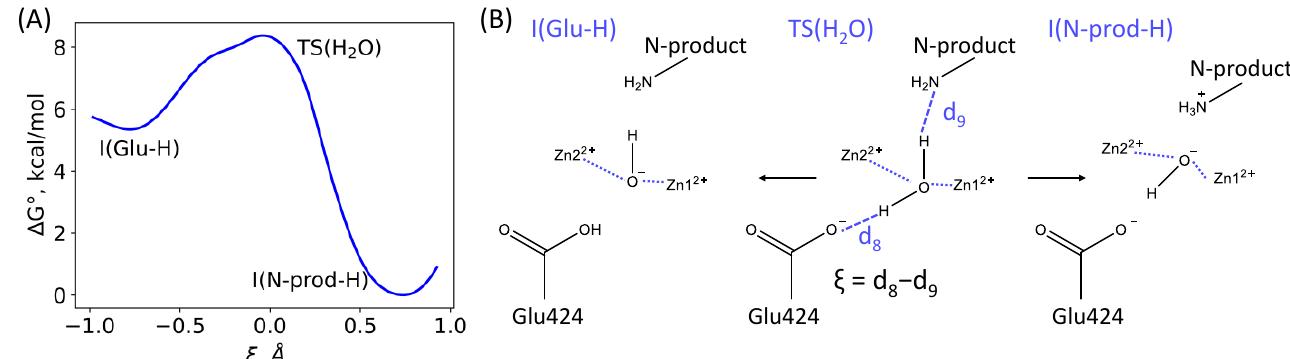
Figure 5. ( A ) The Gibbs energy profile of the enzyme regeneration step. ( B ) Proton transfer pathways at this step. Blue dashed lines are for the distances, d8 and d9, that are included to the reaction coordinate, ξ; blue dotted lines are for the coordination bonds between the water molecule and zinc cations.